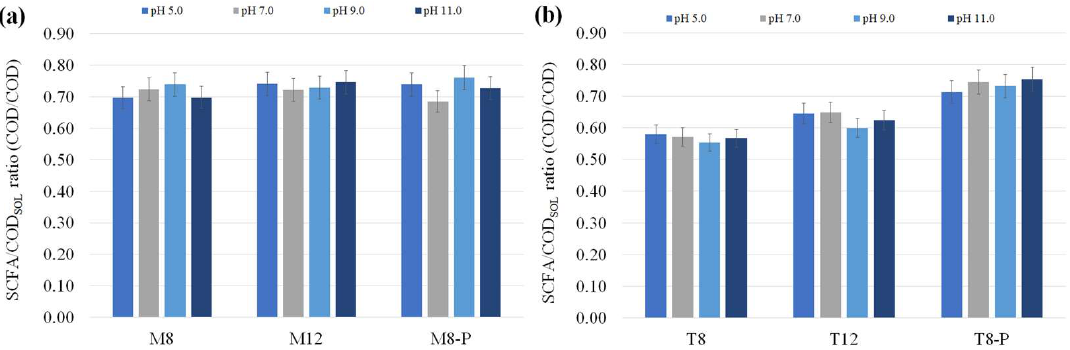
Figure 3. SCFAs/COD SOL ratio (COD/COD) of the mesophilic batch series M8, M12, and M8-P under the initial pH 5.0, 7.0, 9.0, and 11.0 ( A ); SCFAs/COD SOL ratio (COD/COD) of the thermophilic batch series T8, T12, and T8-P under the initial pH 5.0, 7.0, 9.0, and 11.0 ( B ).